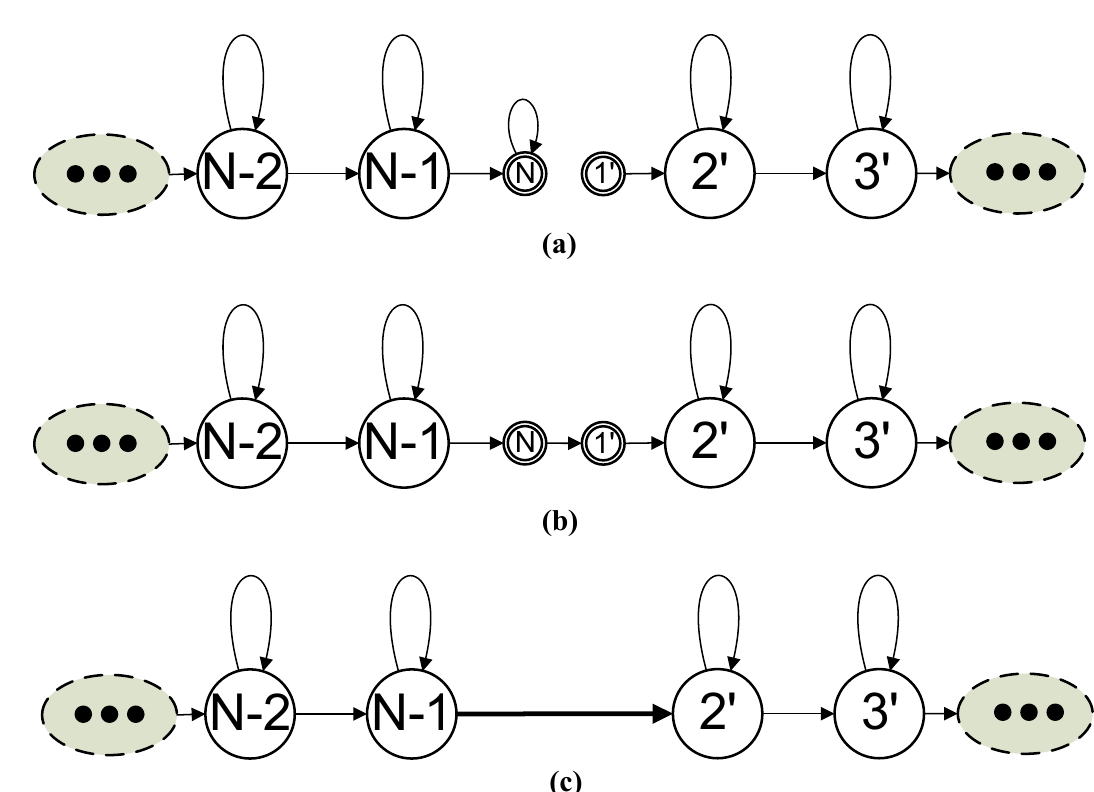
Fig 2. Procedure for connecting two HMMs. (a) Two individual HMMs. (b) The two individual HMMs are concatenated by diverting the target of the self-transition from the ending null state of the first model to the starting null state of the following model. (c) The equivalent HMM of (b) as the two passing-through null states are